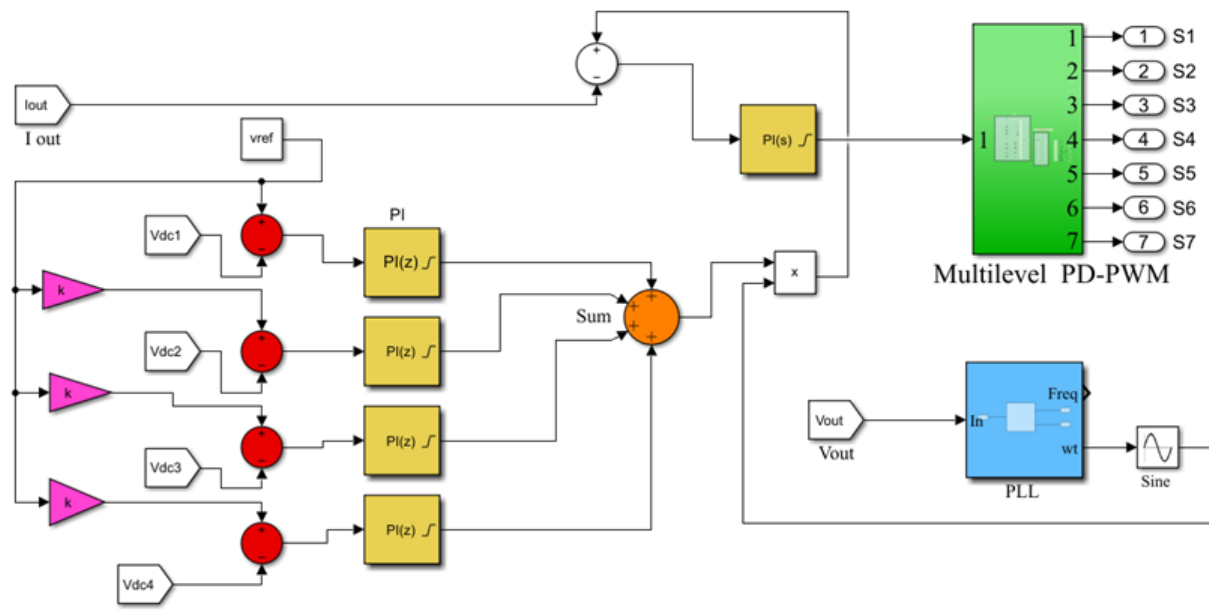
Figure 22. Simulation diagram of a cascaded multilevel control approach.